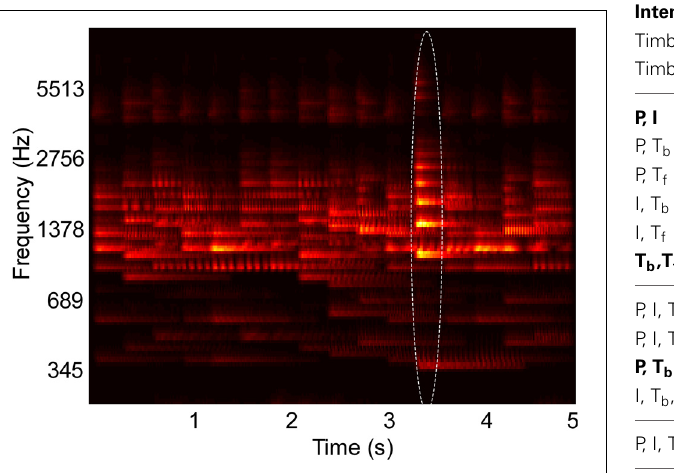
FIGURE 1 | Example spectrogram of stimulus used in behavioral experiments. The spectrogram shows overlapping musical note tokens that compose a scene’s background, and one foreground note, outlined in the image. Their pitch and intensity values are sampled from a constrained distribution of values, emulating a busy scene with natural sounds (Background pitch between 196 and 247Hz). Listeners cannot perceive any individual note but are able to tell the class of sounds playing in the background. One “foreground” note that varies in pitch (Foreground pitch at 350Hz) and intensity (6dB higher than background notes) is introduced at a random location in the scene. In Experiments I and II, foreground tokens only appear in the second half of the scene, while in Experiment III, they can occur at any time. In all experiments, foreground tokens differ from the background in one or more of the following features: Pitch, intensity, and timbre. In the example shown in the figure, timbre was not varied. All tokens were clavichord notes.